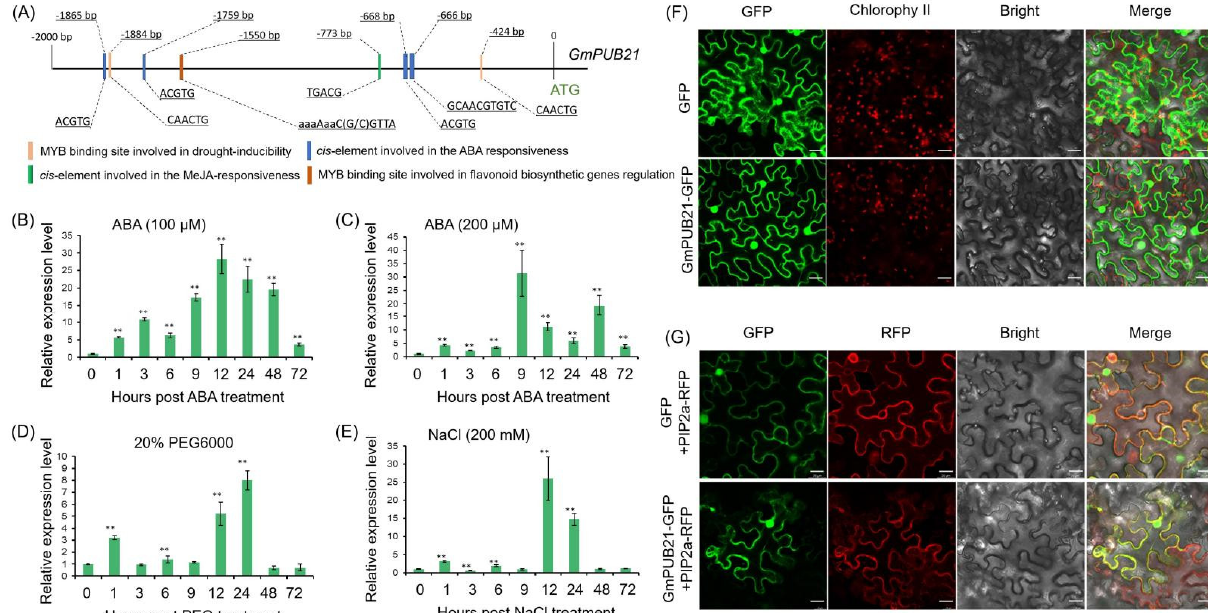
Figure 2. The expression pattern GmPUB21 in soybean under different treatments and subcellular localization. ( A ) Predicted cis −acting elements in the promoter sequence (~2000 bp) of GmPUB21 with PlantCARE. [ ( B ) ABA (100 µM), ( C ) ABA (200 µM), ( D ) 20% PEG, and ( E ) NaCl (200 mM)] were analyzed using quantitative real-time PCR analysis. Leaves of soybean from all the treatments collected at 0, 1, 3, 6, 9, 12, 24, 48, and 72 h after treatment were used for the analysis. Tubulin was used as the internal control. Data are means ± SD from three biological replicates. Asterisks indicate statistically significant differences relative to water treatment (Student’s t -tests, ** p < 0.01). ( F ) Subcellular localization of GmPUB21 in N. benthamiana, GmPUB21−GFP fusion protein or GFP alone expressed in tobacco leaves. ( G ) Co−localization of GFP fusion proteins with plasma membrane marker (PIP2a) in tobacco leaves. The fluorescence signals were monitored by confocal microscopy, and the images were taken at 2 days post−infiltration. Scale bars, 20 µm.